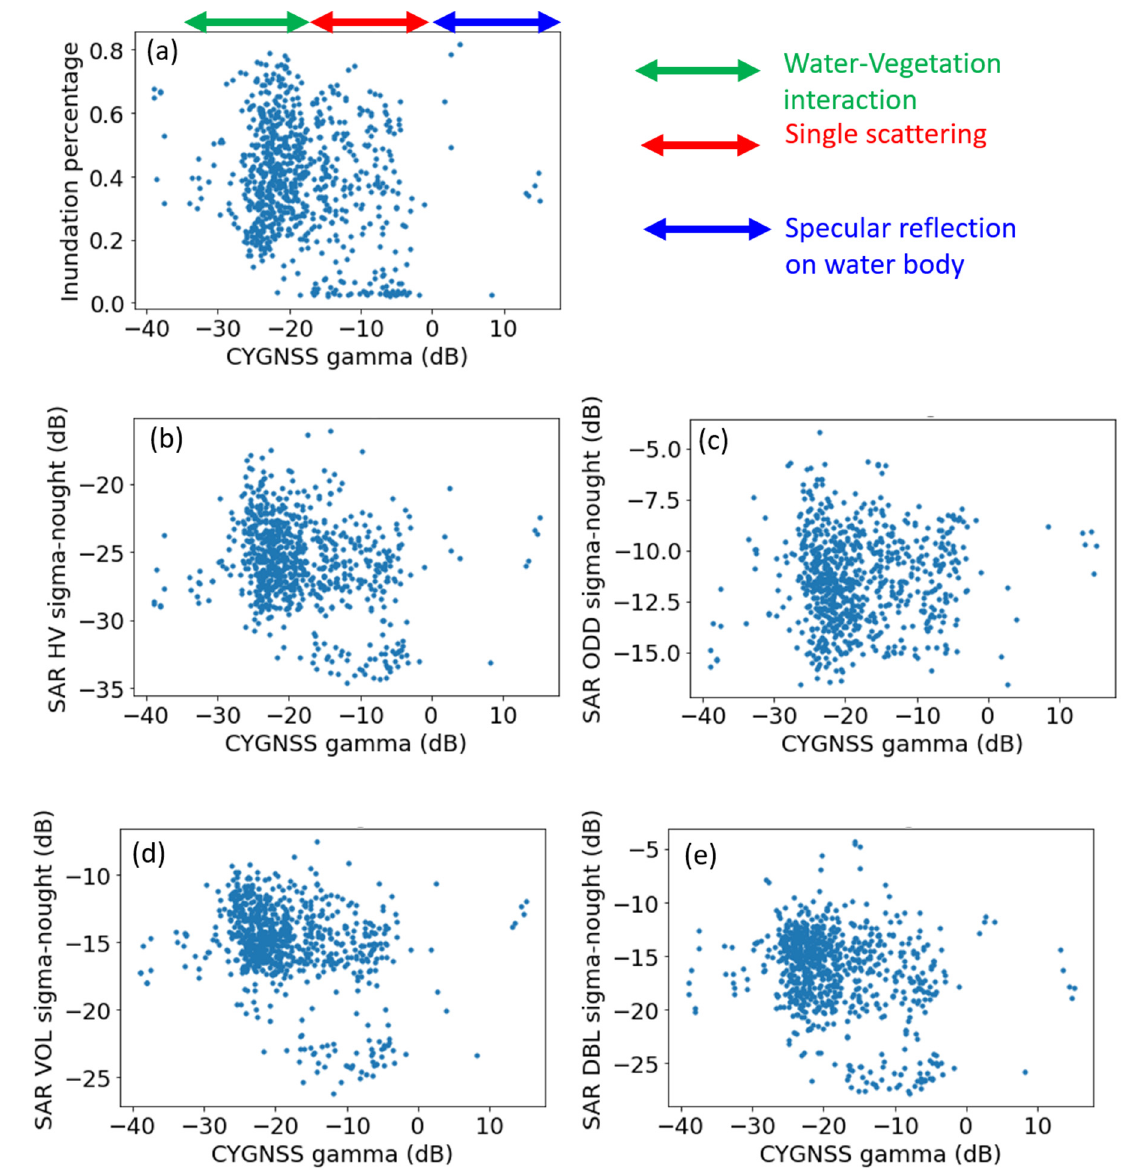
Figure 9. Two-dimensional scatterplots between the CyGNSS reflectivity Γ (dB) and PALSAR-2 based spatial inundation percentage ( a ) and PALSAR-2 back scatters σ 0 (dB) values (( b ) HV, ( c ) odd scattering, ( d ) volume diffusion, ( e ) double bounce) at specular points with 30–35° incidence angles. The statistical analysis results representing these relationships are described in Tables S2.